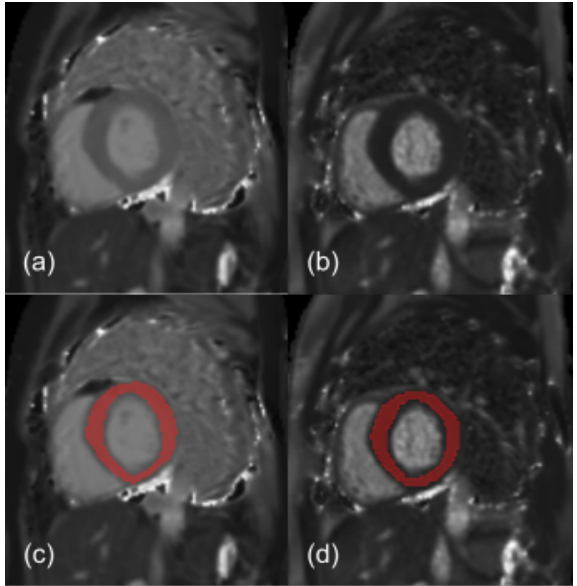
Figure 1. T1 ( a ) and T2 ( b ) maps (short-axis view) of a representative HCM patient, with the corresponding manually segmented myocardium region of interest (ROI) showed in panel ( c , d ), respectively. Myocardium area size ranged from 740 mm 2 to 2370 mm 2 across enrolled HCM patients. Typical myocardial T1 and T2 values were approximately 997 ms and 53 ms (median values across HCM patients),